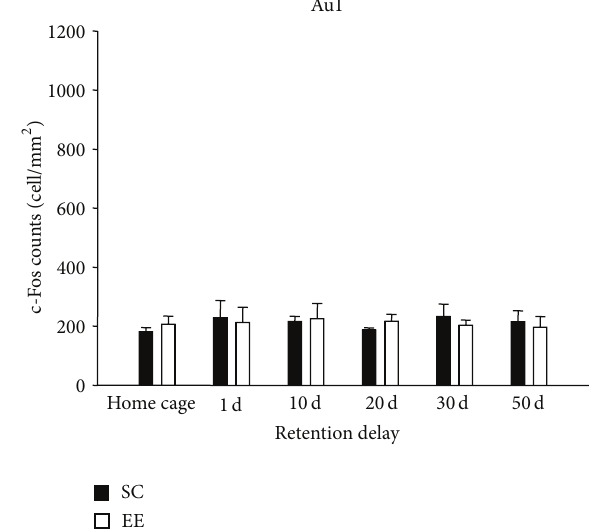
Figure 6: c-Fos protein expression in Au1. The data showed no difference between groups (two-way ANOVA, housing condition factor, 𝑃 = 0.996 , day of probe test factor, 𝑃 = 0.943 , housing condition × day of probe test interaction, 𝑃 = 0.938 ). In all probe tests, EE and SC groups did not differ from their home cage